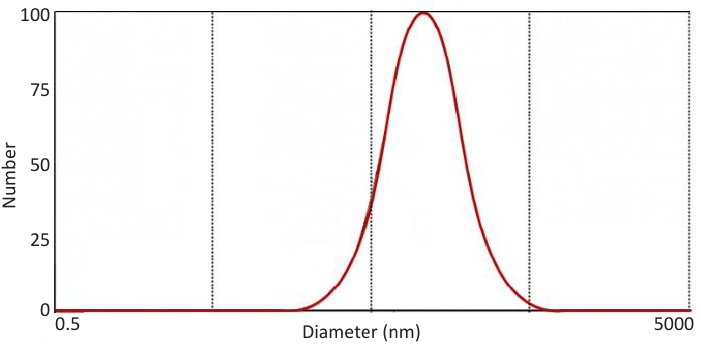
Fig. 4. Logarithmic size distribution of gelatin